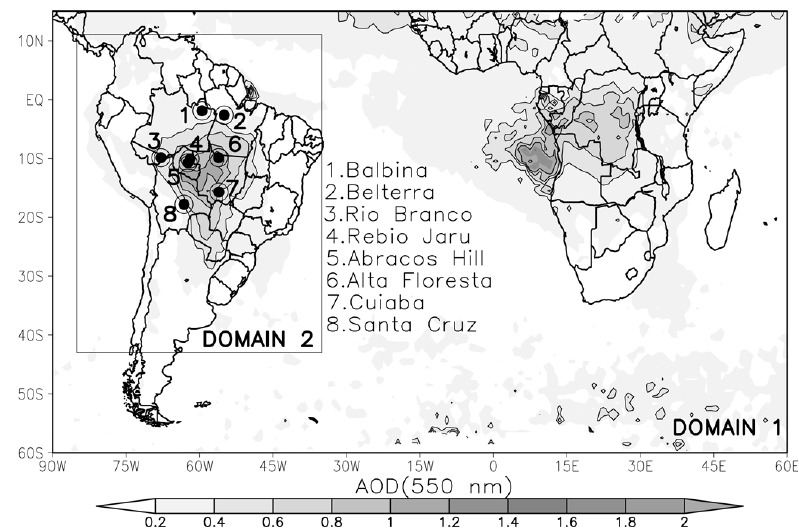
Fig. 1. Geographic locations of analyzed experimental sites depicted along the mean field of aerosol optical depth (AOD) at 550nm during the 2002 biomass burning season in South America obtained from MODIS aboard the TERRA